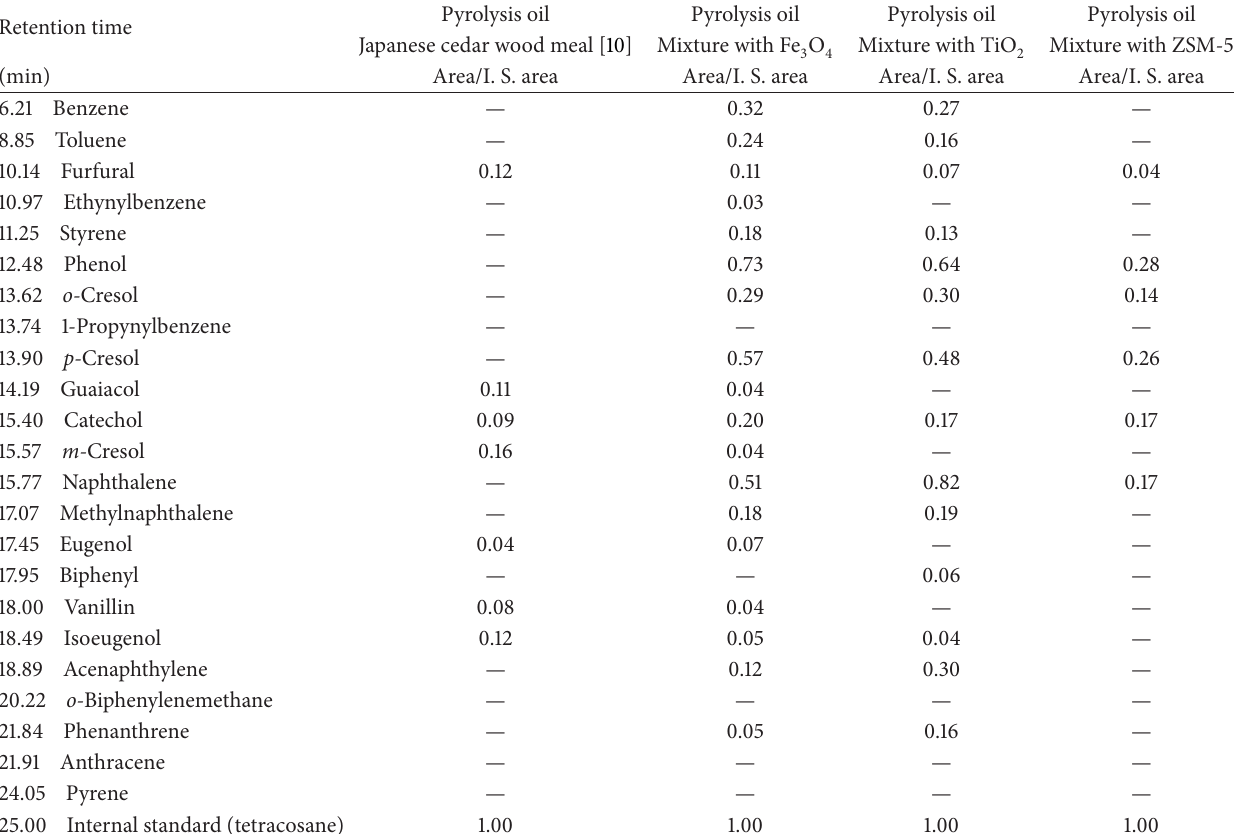
Table 1: GC-MS semiquantitative analysis of pyrolysis oil components obtained from Japanese cedar wood meal/catalyst (1: 1w/w) mixtures pyrolyzed at 500 ∘ C.